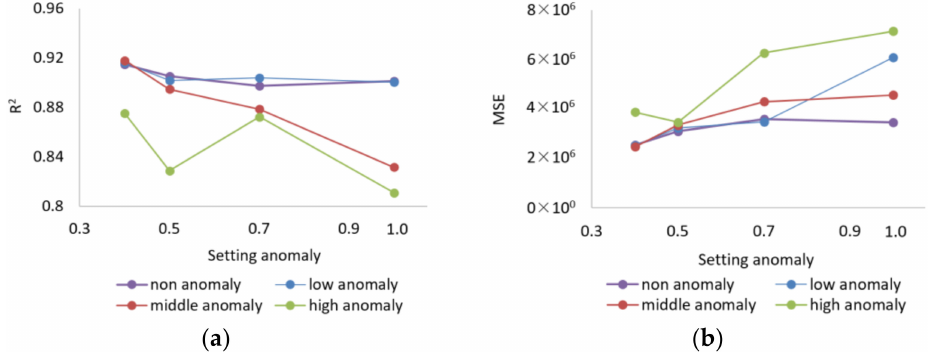
Figure 9. The modelling performance of data cleaning method with various anomaly threshold settings in terms of ( a ) R 2 and ( b ) MSE.